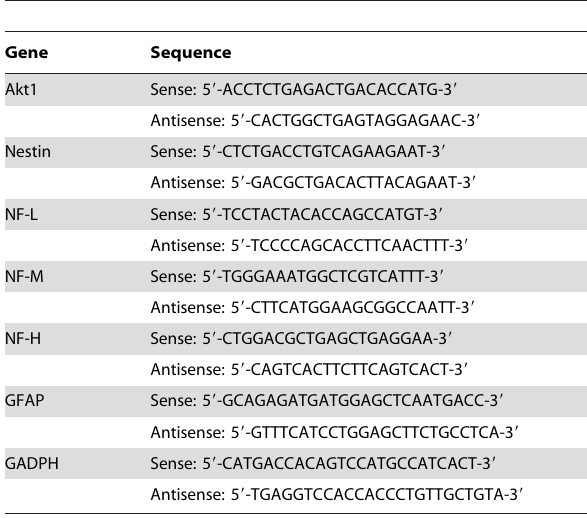
Table 1. PCR primer sequences for cell type-specific markers (all